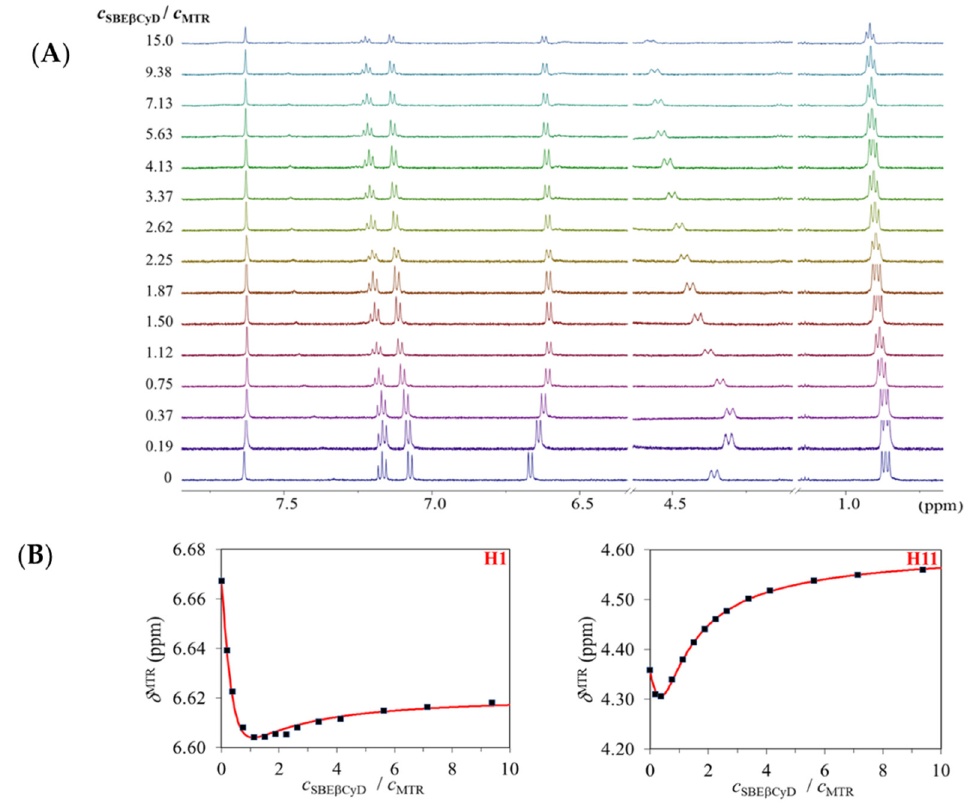
Figure 2. Representative 1 H NMR multiplet displacements ( A ) of the MTR 1 H resonances upon titration with SBE β CyD. Subplot ( B ) shows the selected titration profiles of the H1 and H11 MTR resonances. Red curves were fitted by assuming the presence of both the MTR ∙ SBE β CyD and the 2MTR ∙ SBE β CyD species.